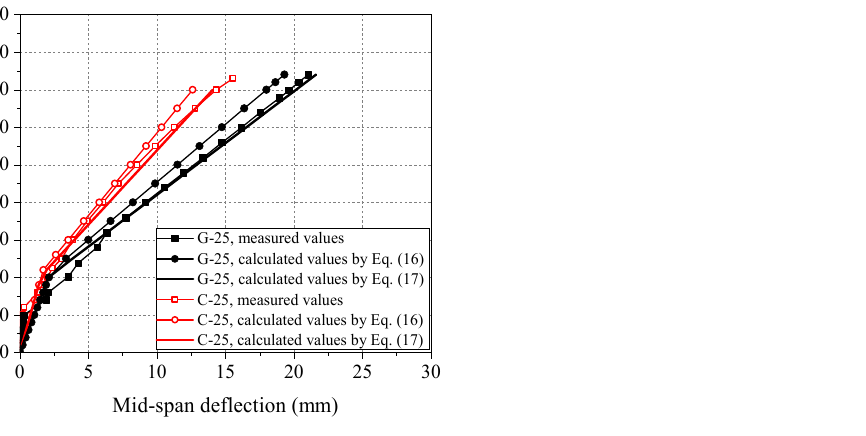
Figure 10. Comparison between measured and calculated values of mid-span deflection of FRP- reinforced concrete beams at room temperature. Table 7. Comparison between measured and calculated values of short-term stiffness of tested beam specimens at room